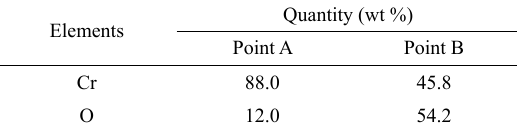
Table 6. Average absorptance of the substrate and sample 1 and 5.